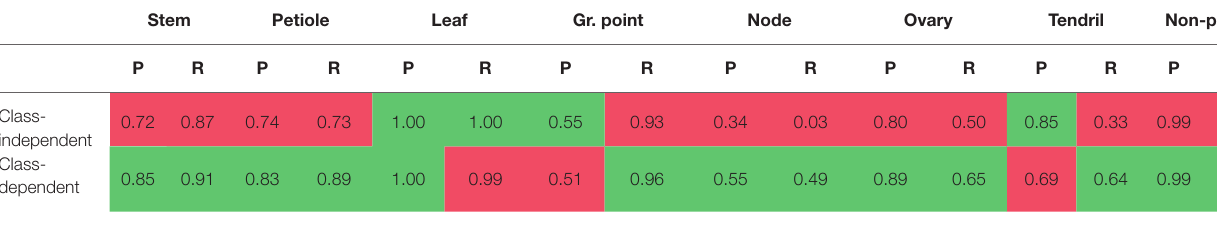
TABLE 2 | Precision (P) and Recall (R) per class, for the class-independent and the class-dependent selection of anchor points. Stem Petiole Leaf Gr. point Node Ovary Tendril